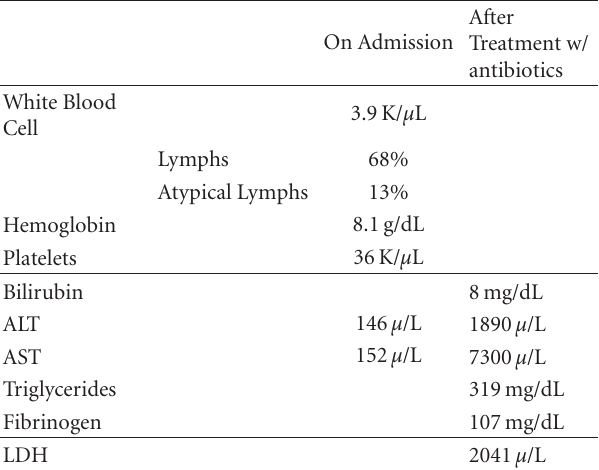
Table 1: Pertinent Lab